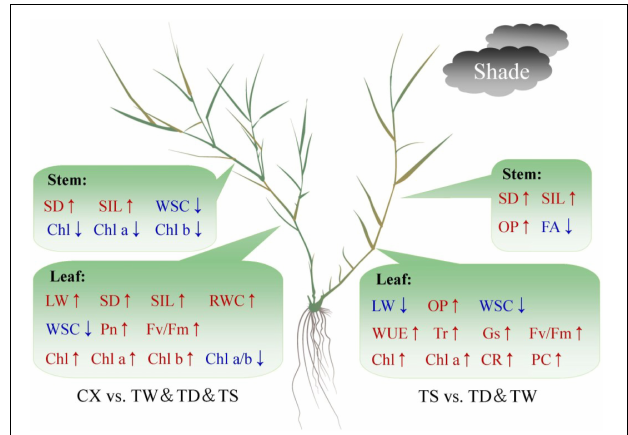
FIGURE 9 | Differential responses to shade stress between common and hybrid bermudagrasses (CX vs. TW&TD&TS) or among three different hybrid bermudagrasses (TS vs.